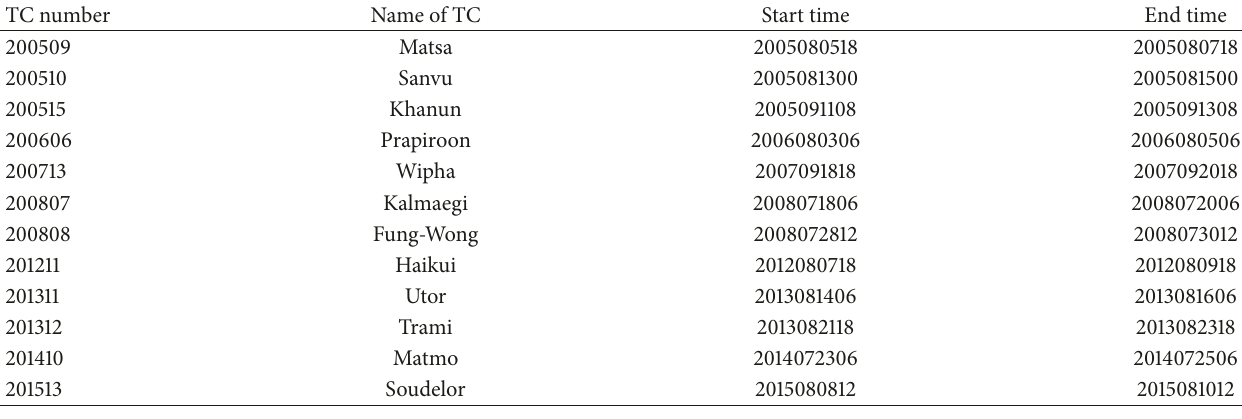
Table 1: The TCs landing Chinese mainland during 2005 to 2015.